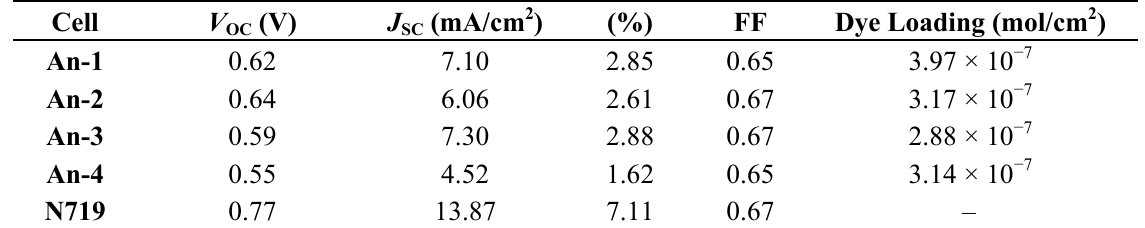
Table 2. Dye-sensitized solar cells (DSSCs) performance parameters of the